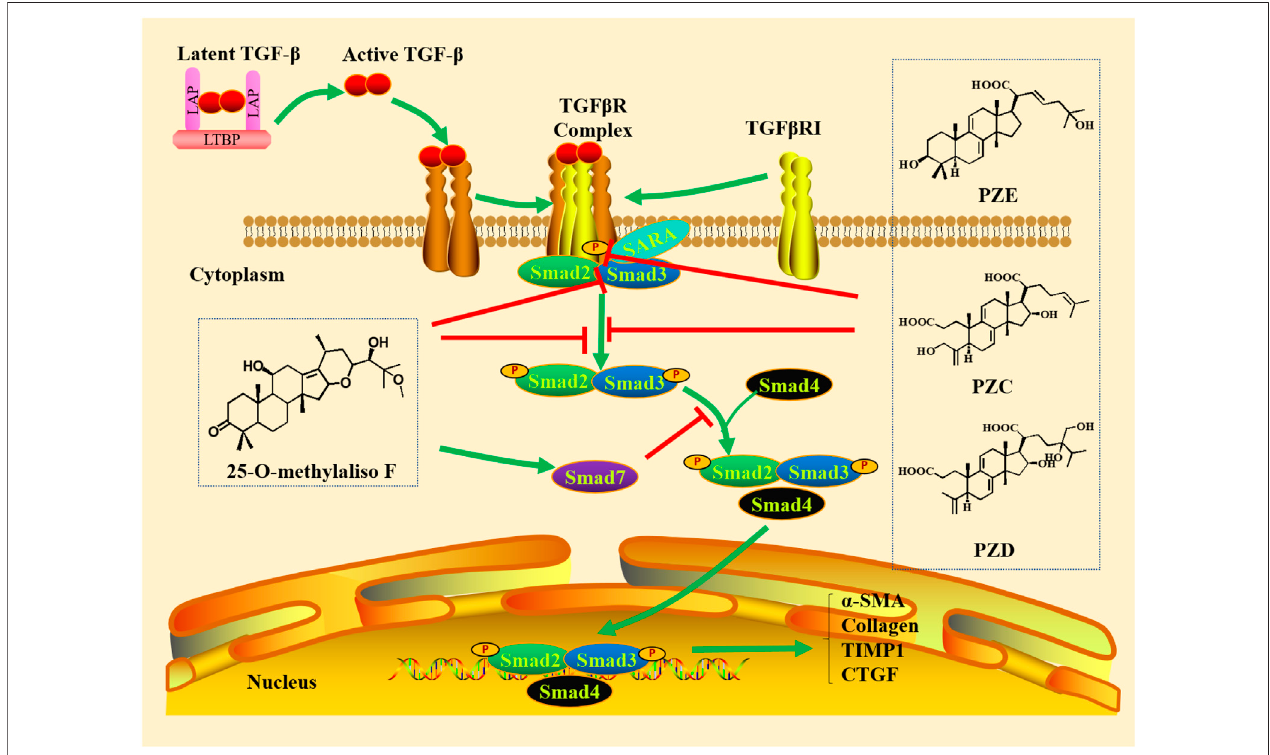
FIGURE 1 | Canonical TGF- β /Smad pathway. TGF- β synthesized in precursor form combines with latency-associated peptide (LAP) that promotes attachment with LTBP through the formation of disul fi de bonds, which is released from the LAP and LTBP and becomes active when exposed to various stimuli. The active TGF- β binds to TGF β RII, which recruits and activates TGF β RI through phosphorylated the GS domain in TGF β RI. TGF β RI phosphorylates and activates Smad2 and Smad3 (R-Smads). Smad4 combined with phosphorylated R-Smads to form a trimer complex for transcriptional regulation. Smad7 is involved and acts as a negative feedback regulation loop to regulate the target genes that regulate cell